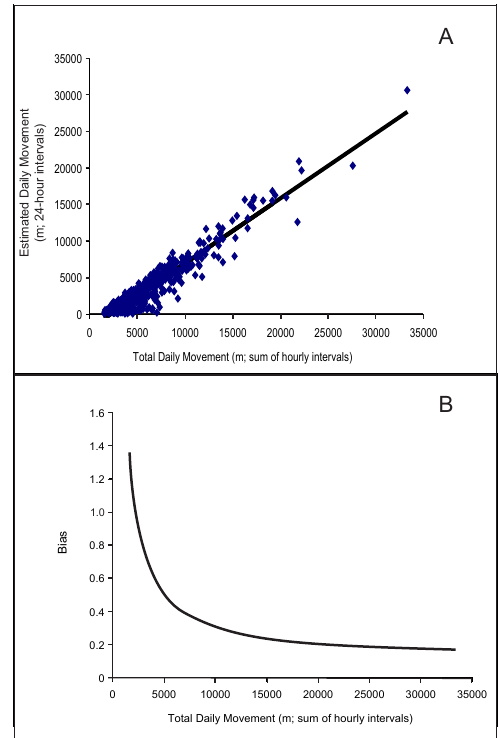
Fig. 4. A) Relationship between total daily movement (TDM; sum of hourly intervals) and estimated